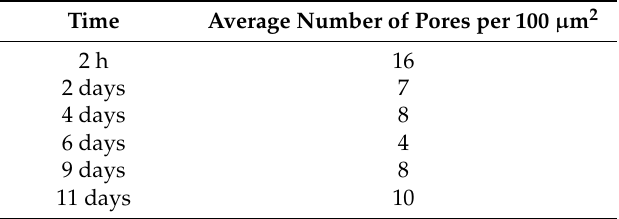
Table 2. An average number of pores on the surface of the swelling PDL